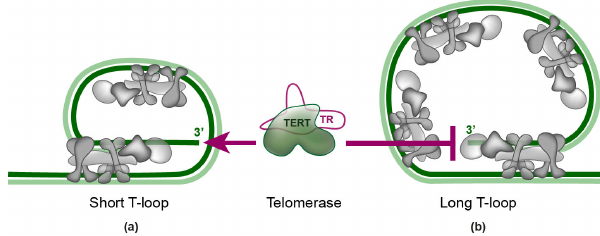
Figure 2. T ‐ loop formation as a factor for telomere length regulation. The 3‘ overhang invades the Figure 2. T-loop formation as a factor for telomere length regulation. The 3 (cid:48) overhang invades the double ‐ stranded telomeric DNA and, by base ‐ pairing with the C ‐ strand, displaces the G ‐ strand, double-stranded telomeric DNA and, by base-pairing with the C-strand, displaces the G-strand, which causes the end of the telomere to be tucked in. Double-stranded DNA-binding proteins of shelterin, TRF1 and TRF2, mediate and fold DNA to the t-loop. The amount of shelterin that is bound to telomeres is dependent on the t-loop length. ( a ) A short t-loop with less abundant shelterin has a lower probability that shelterin covers and hides the 3 (cid:48) overhang of telomeric DNA. Telomerase can extend telomeric DNA. ( b ) The long t-loop is occupied by more shelterin complexes, so the probability that the 3 (cid:48) overhang is covered and hidden is higher. Telomerase access to the 3 (cid:48) end single-stranded DNA is blocked and no DNA extension